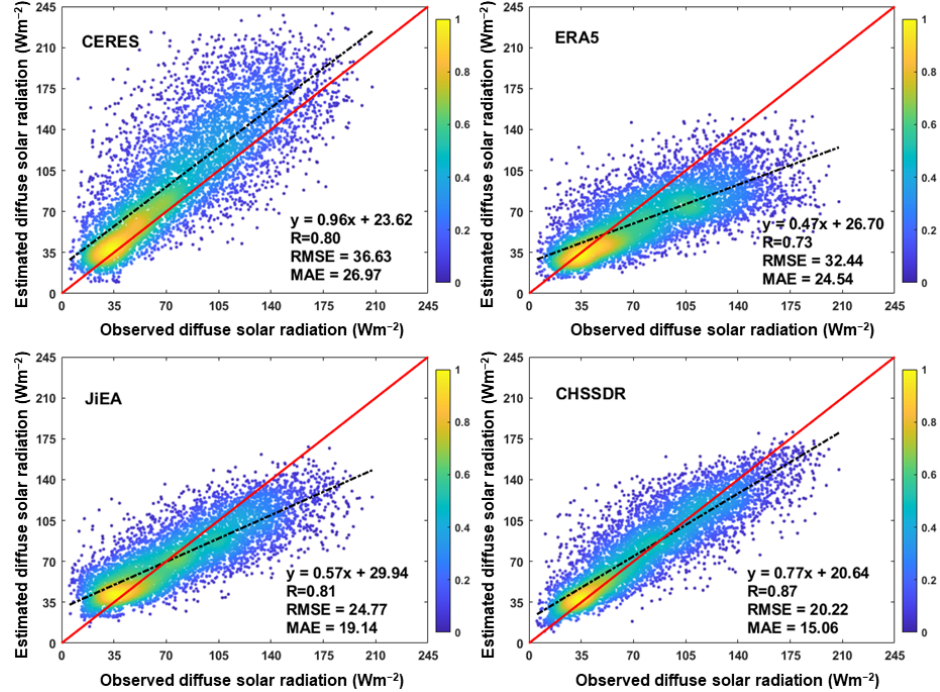
Figure 5. Density scatterplots for different diffuse solar radiation products and ground-based observation data.